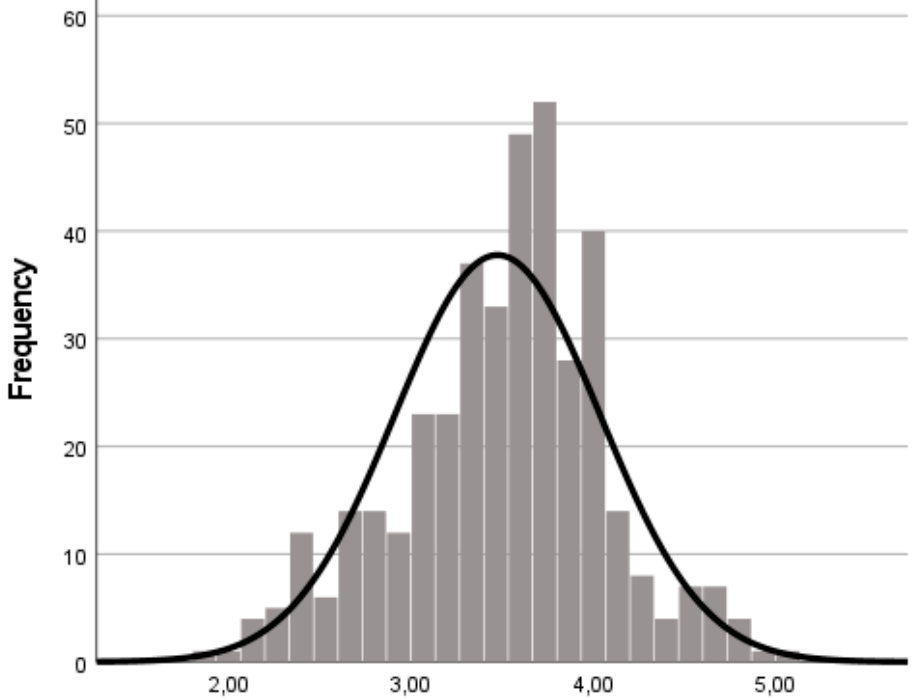
Figure 1. Histogram of AAQ scores (Mean = 3.47; DP = 0.56; Mode= 3.67; Median = 3.53; Percentile 25 = 3.13; Percentile 50 = 3.53; Percentile 75 = 3.80; n = 400).